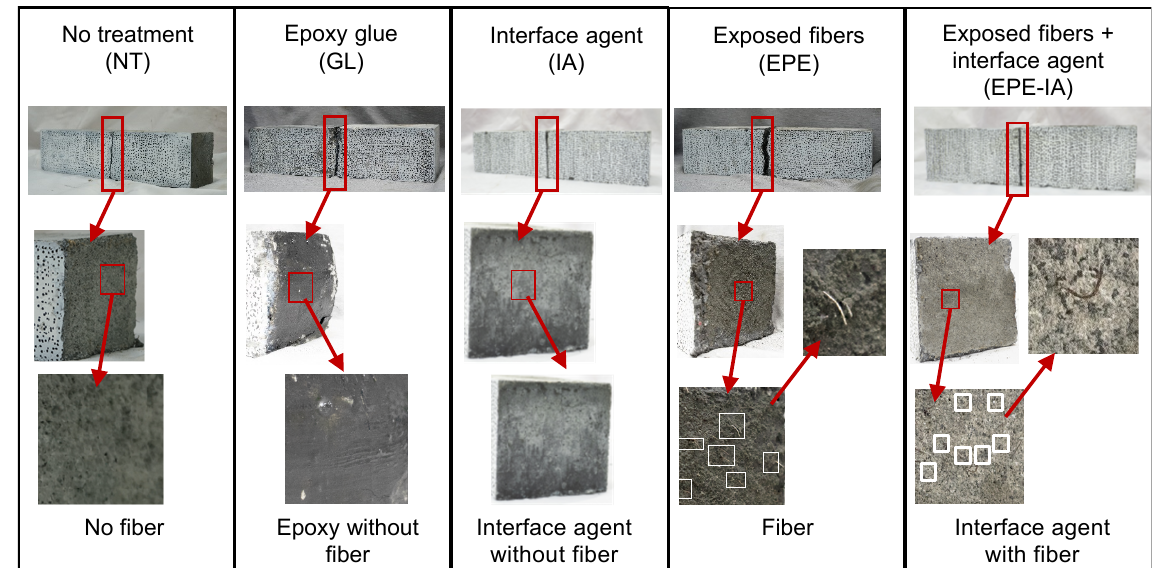
Figure 6. Failure modes and surfaces of the